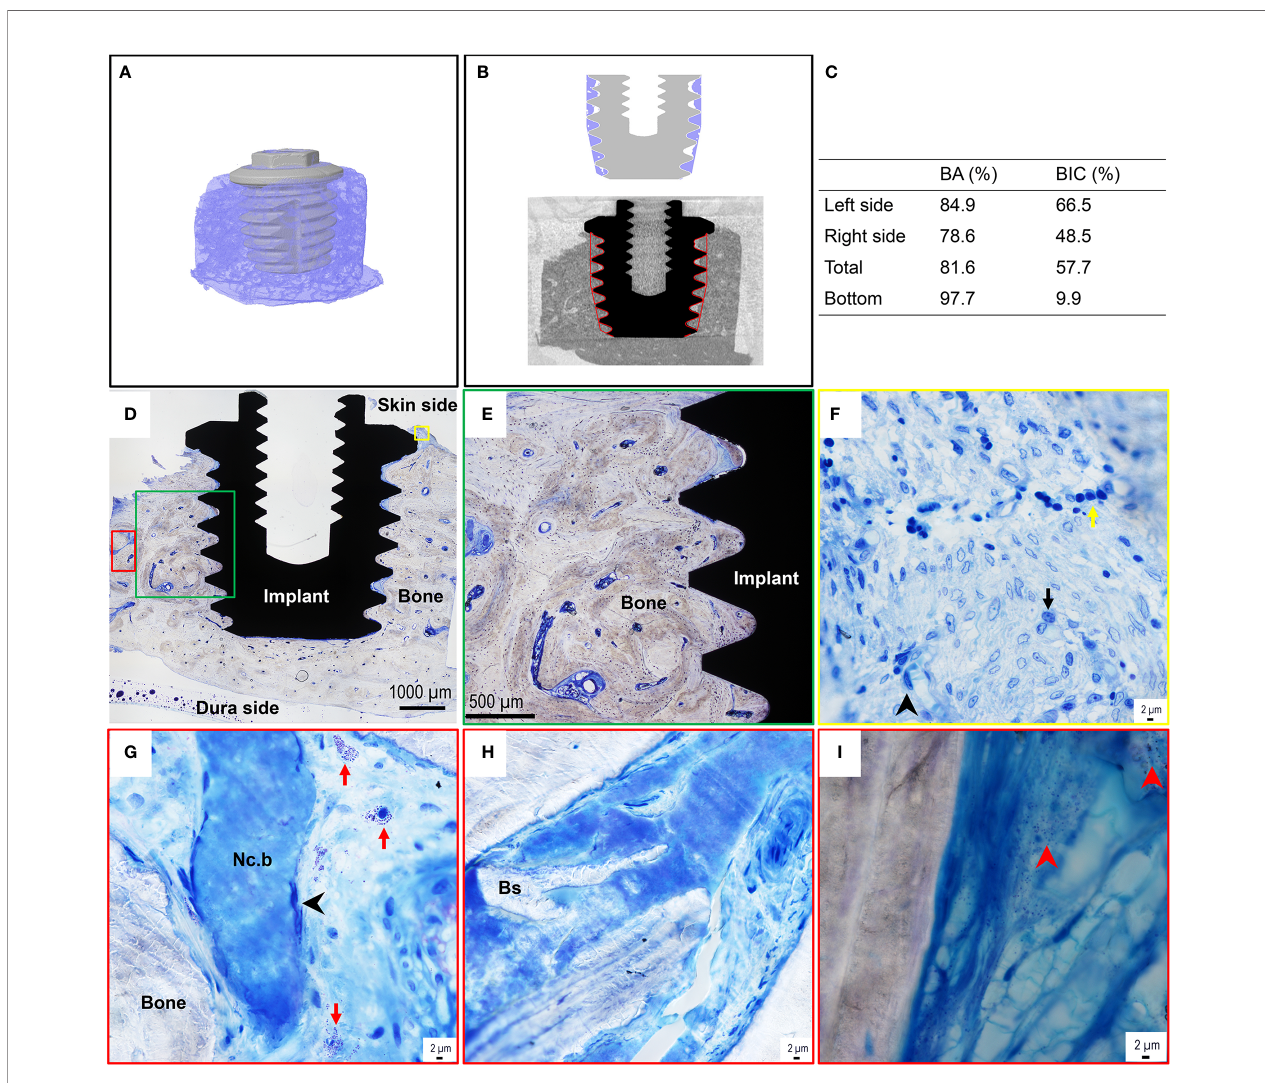
FIGURE 5 | Micro-CT images, histomorphometry, and histological assessment of the bone-implant sampleof the BAHS implant. (A) MicroCT 3D reconstruction of the retrieved implant with surroundingbone. (B) Region of interest and segmentation of the bone surroundingthe implant. (C) Histomorphometric data, BA=Bone area, BIC=Bone to implant contact. (D) Toluidine blue-stained section shows the implant integrated with the recipienttemporal bone site, with dense mature bone fi lling the implant threadsand incontact with the titanium surface in most of thethreads. The green, yellow and red boxes in (D) represent selected regionspresented at higher magni fi cations in (E – I) , respectively. (F) Toluidine blue-stained sectionsat highmagni fi cation show an in fl ammatoryin fi ltrate in the top region atthe interface of bone with the top fl ange of the implant. The in fl ammatory in fi ltrate consists of mainly chronic in fl ammatory cells, containing mononuclear/macrophage, lymphocyte, and plasma celltypes (exempli fi ed by the black arrowhead,black arrow,and yellow arrow in (F) , respectively). (G,H) On several occasions, necrotic bone (Nc.b) and bone sequesters (Bs) were found in cavities of the surroundingbone. The necrotic bone islets alwaysappearedsurrounded byspindle-shaped elongated macrophages [exempli fi edby the black arrowhead in (G) ].Mast cells were frequently detected in the bone cavities [some are indicated bythe red arrow in (G) ]. (I) The Giemsa-stained section shows the presence of coccoid bacteria-likemicrostructures (exempli fi ed by the red arrowheads) insome cavities of the